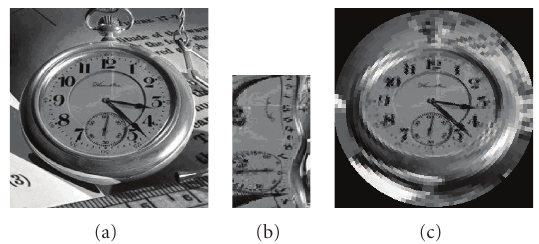
Figure 2: (a) Cartesian image, (b) log-polar image, and (c) recon- structed Cartesian from log-polar image.